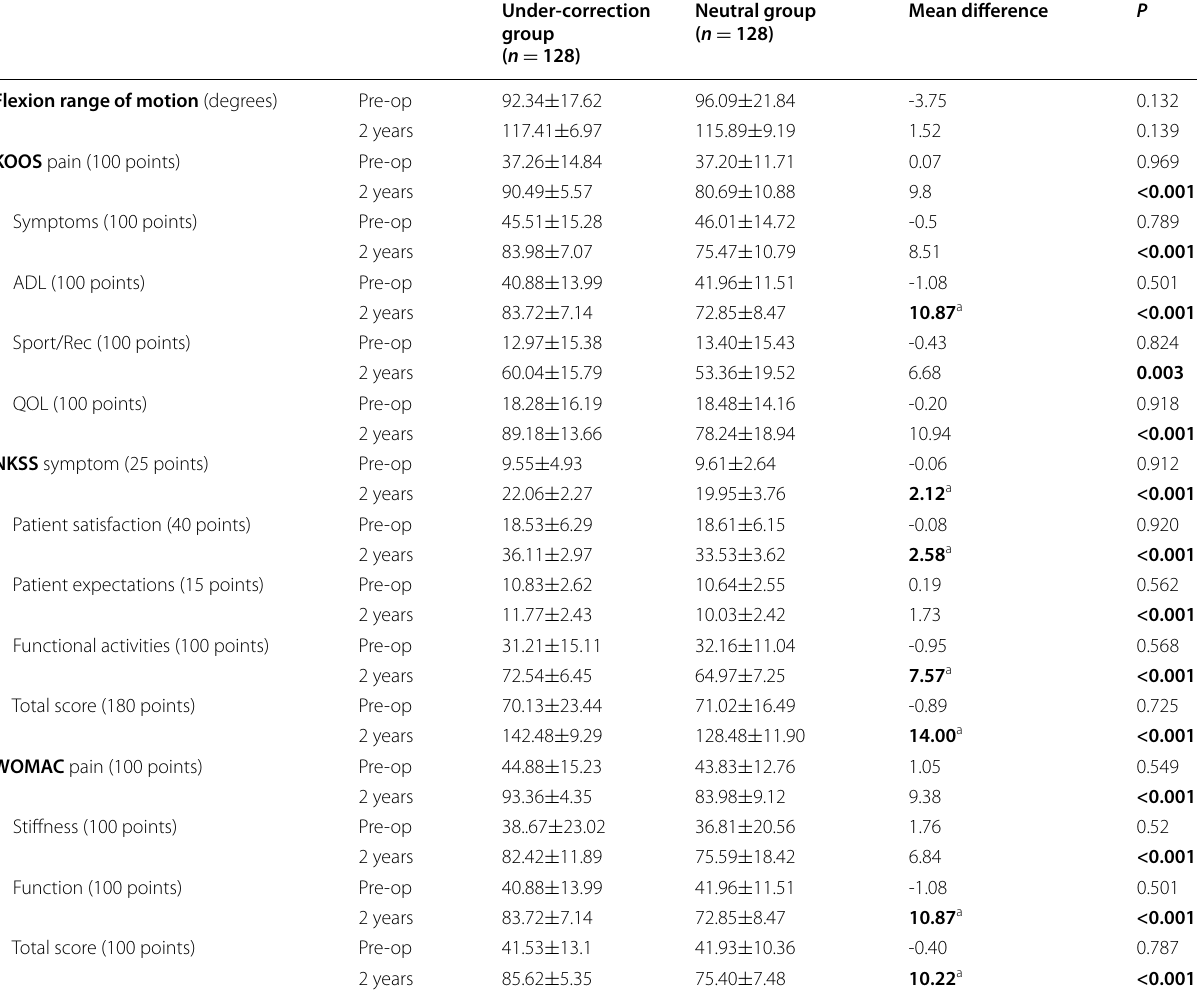
Table 4 Comparison of the between‑group